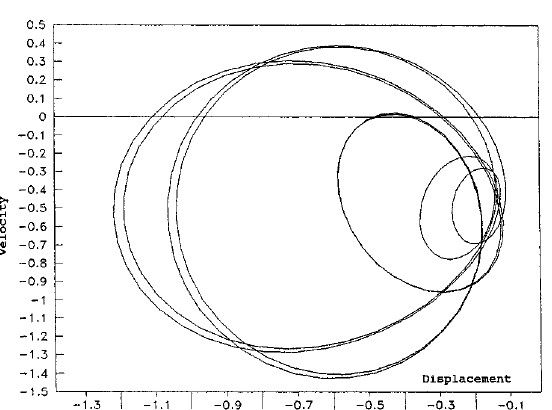
Fig. 5e. Phase diagram q = 0 : 302917.